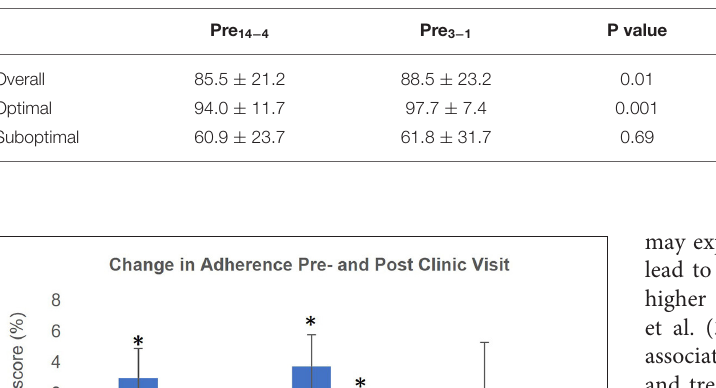
TABLE 2 | Mean adherence per study time point.